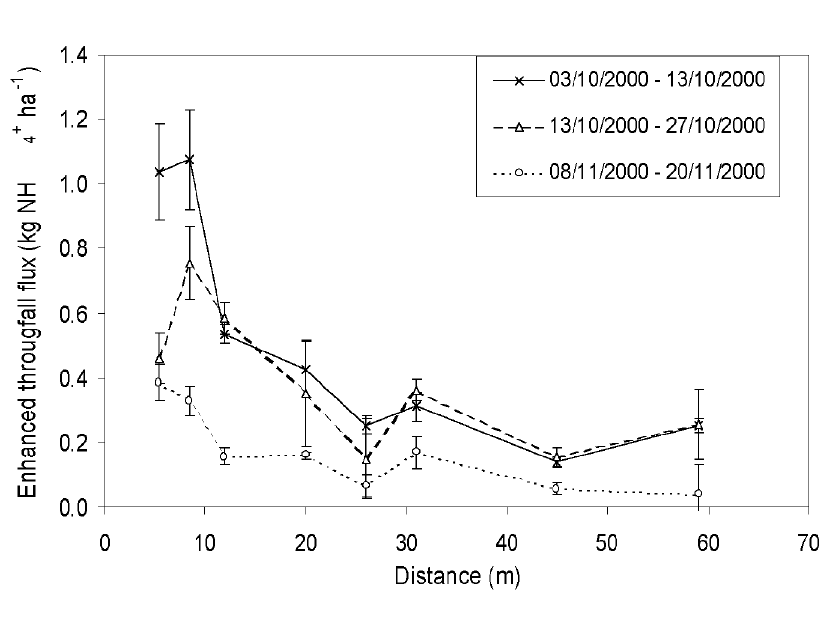
FIGURE 5. Enhancement of throughfall NH 4+ fluxes due to the ammonia release along a transect away from the source for three example sample periods. Error bars are ± 1 standard error of the measurements at each